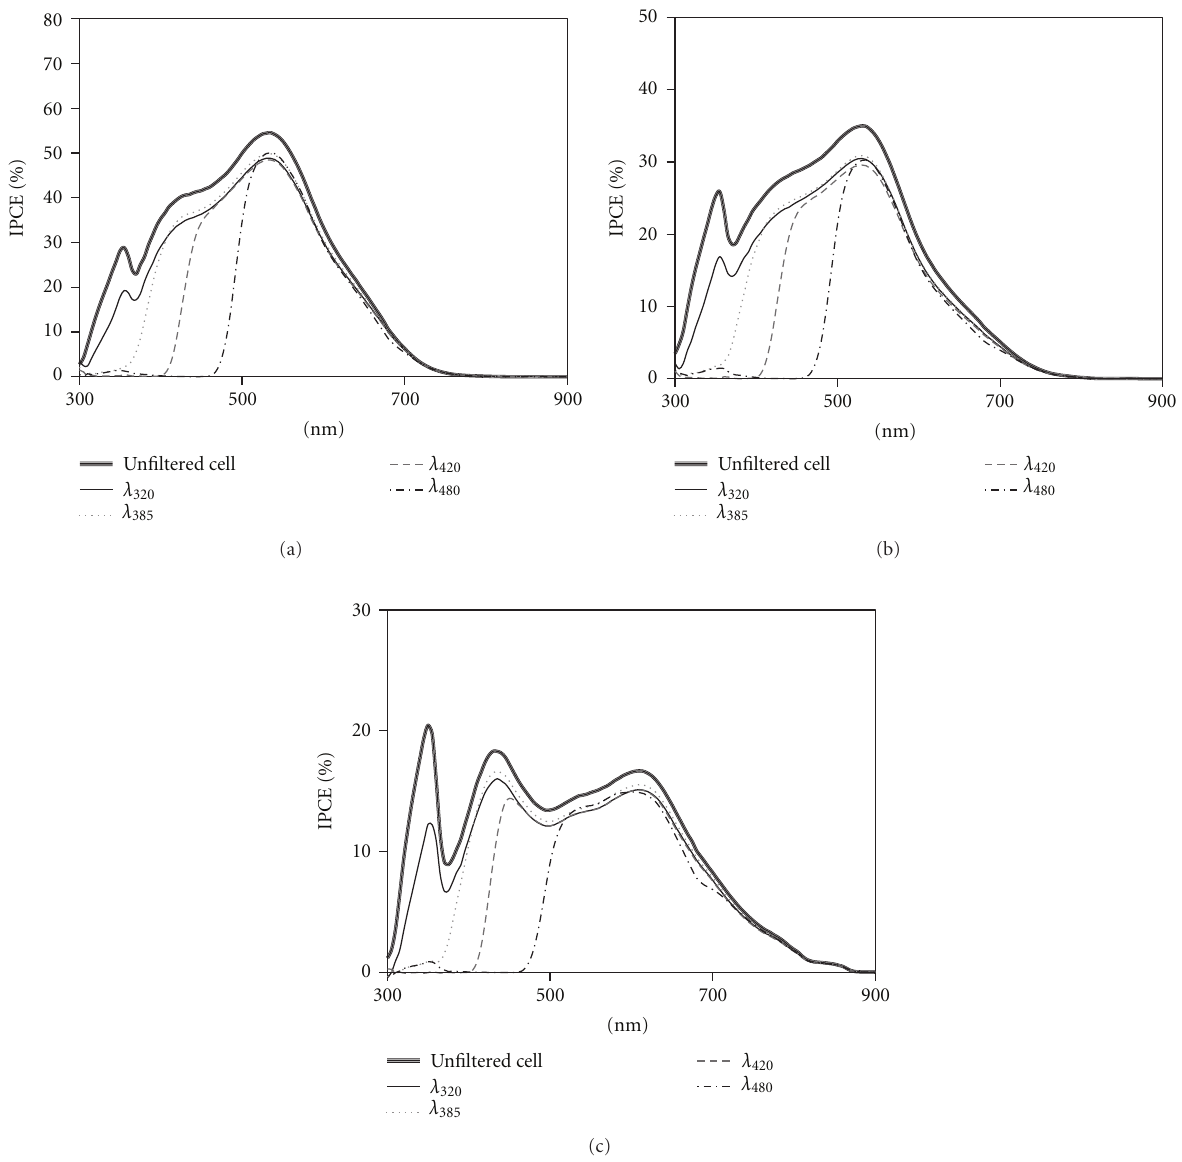
Figure 4: The e ff ects of filtering upon the IPCEs of DSCs made with three di ff erent dyes: (a) N719, (b) Z907, and (c) N749.